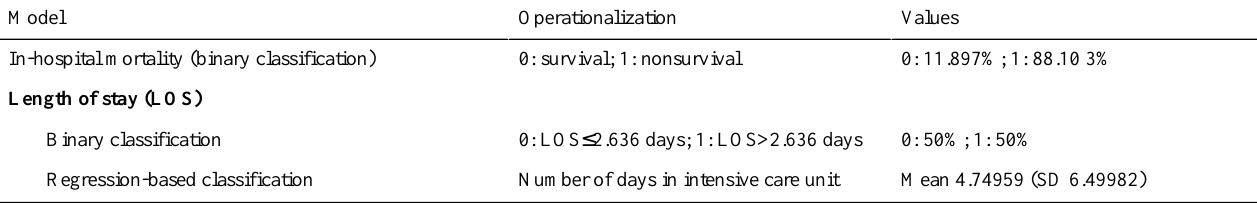
Table 1. Descriptive statistics for outcome variables in the two models. ValuesOperationalizationModel